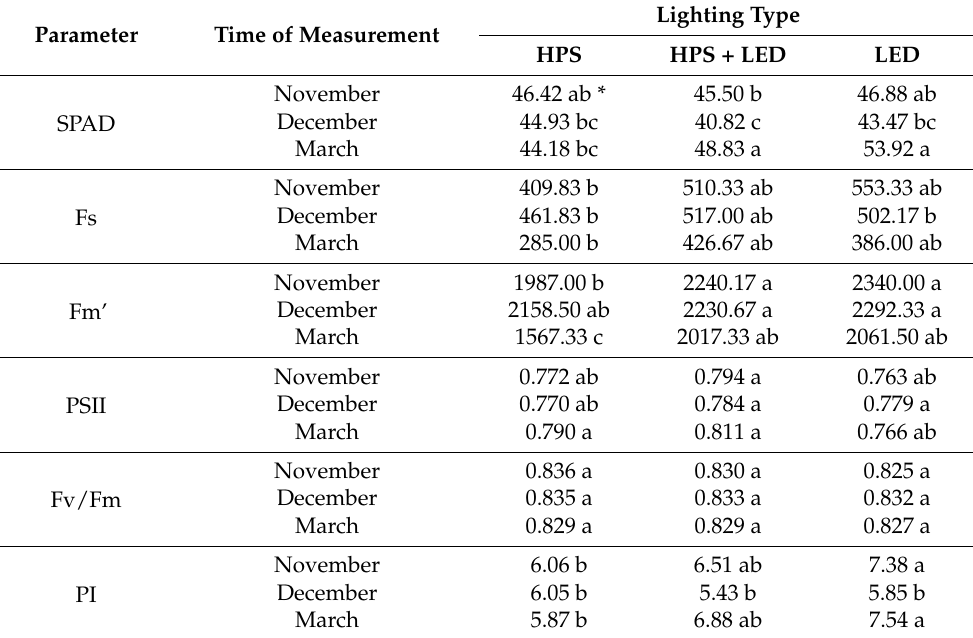
Table 3. Effect of lighting type and time of measurement on the value of the chlorophyll a fluorescence parameters and SPAD in old leaves.